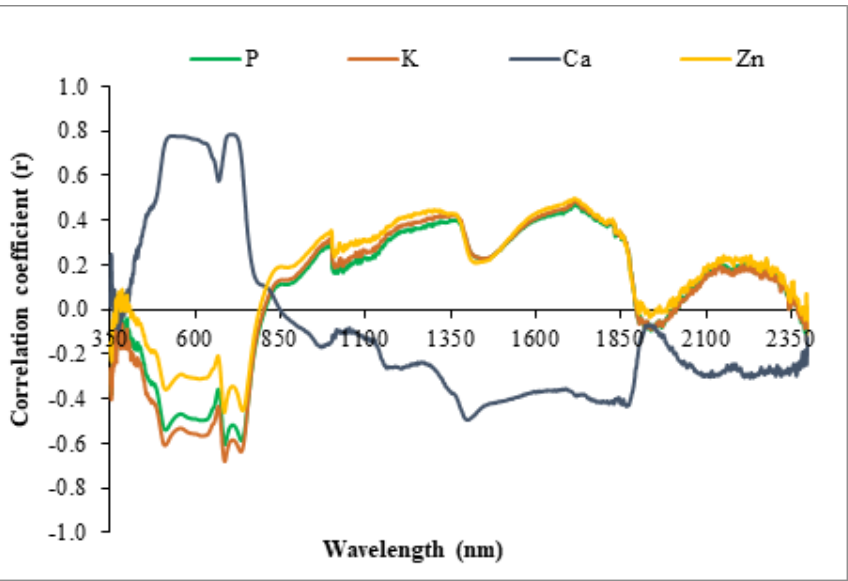
Figure 6. Correlogram between reflectance and the P, K, Ca and Zn content in leaves of Vigna unguiculata (L.) Walp.